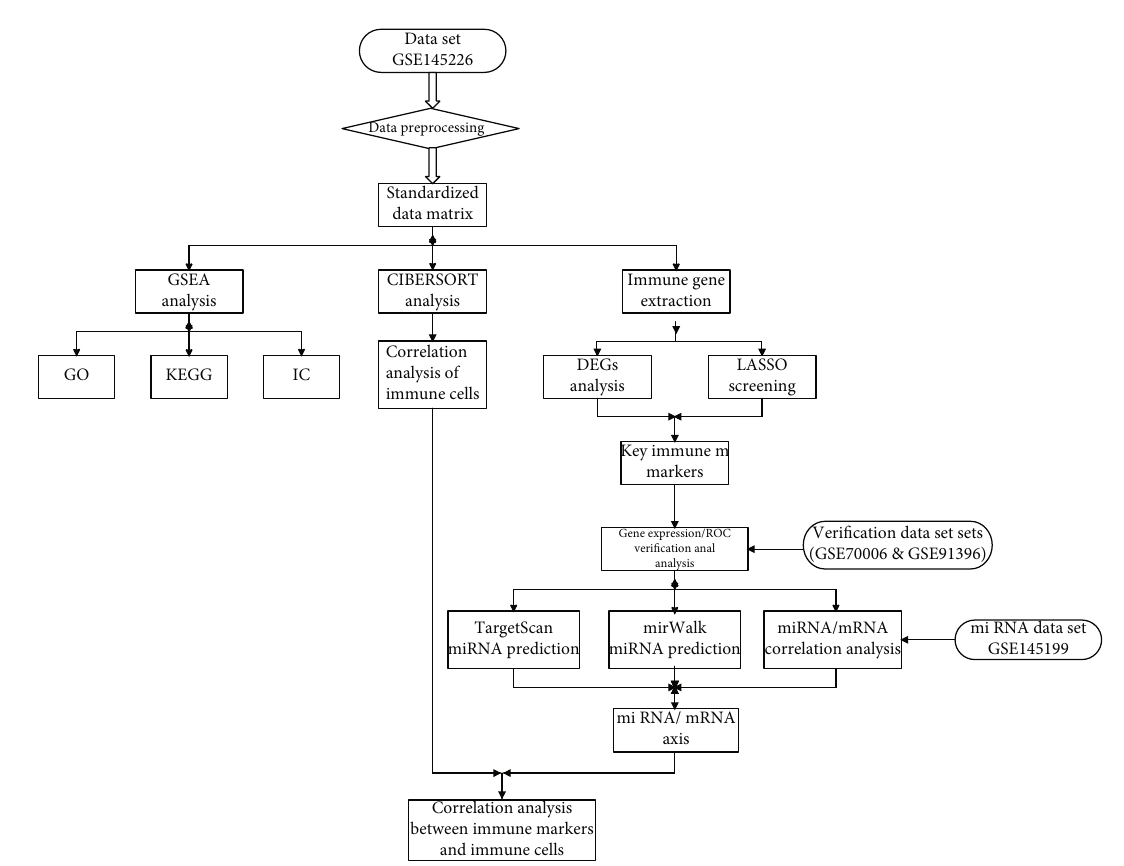
Figure 2: Flow chart of research analysis. GSEA: gene set enrichment analysis; GO: gene ontology; KEGG: Kyoto Encyclopedia of Genes and Genomes; IC: immunological characteristics; DEGs: di ff erential expressed genes; LASSO: least absolute shrinkage and selection operator; ROC: receiver operating characteristic.